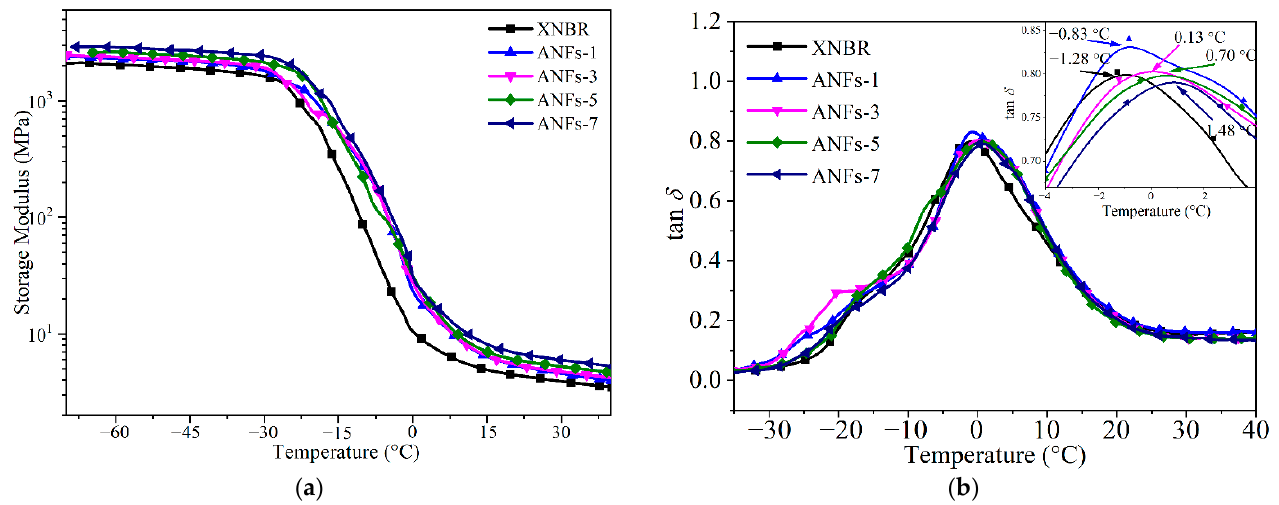
Figure 5. Temperature dependence of ( a ) E ′ and ( b ) tan δ for ANF/XNBR nanocomposites.